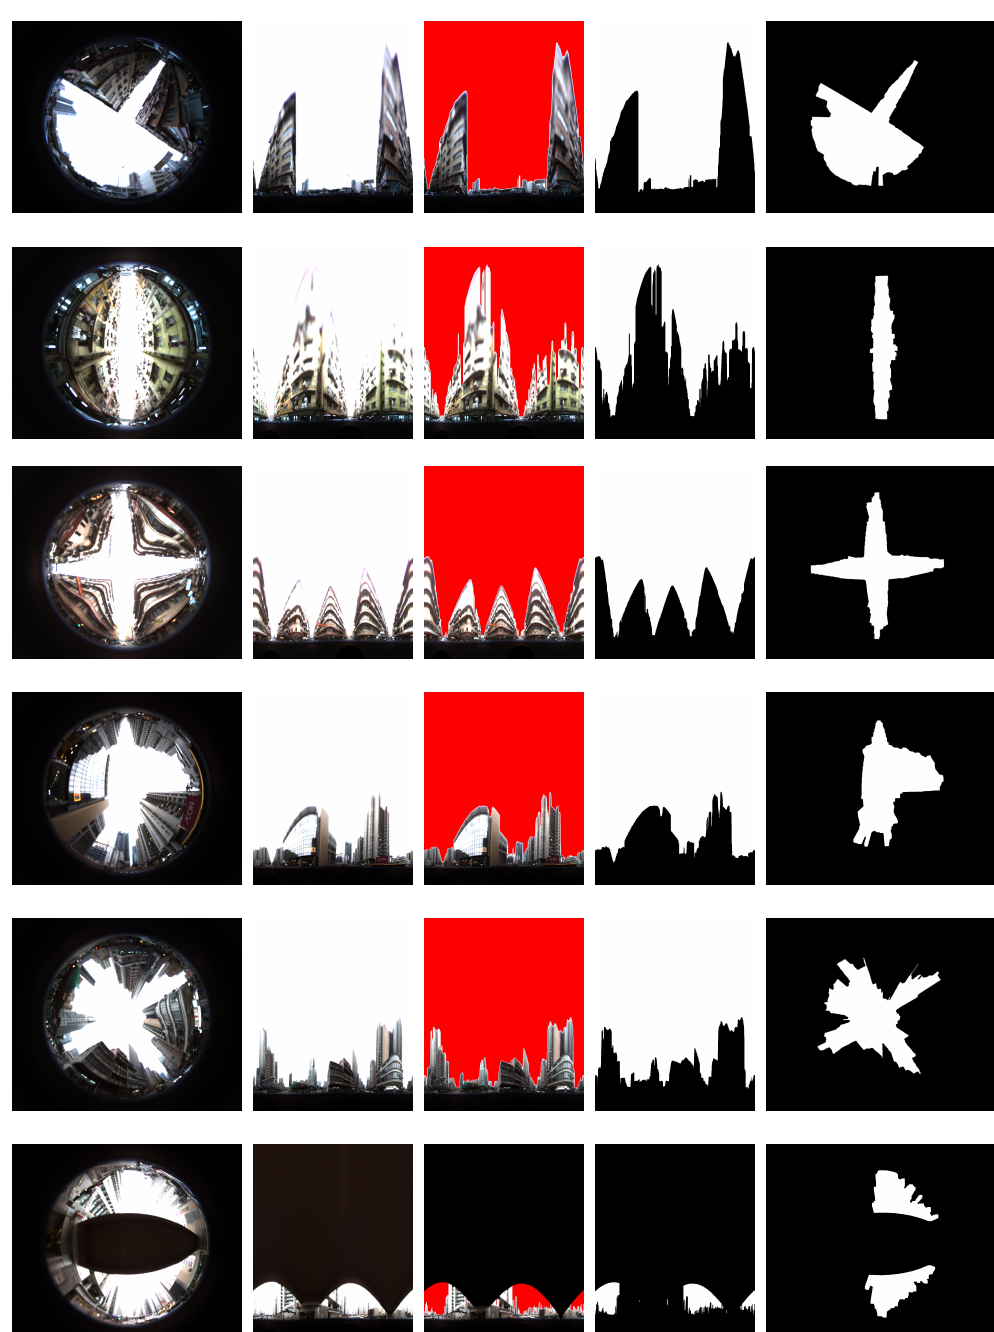
Figure 12. Qualitative evaluation of sky region segmentation. The first column shows the original images, the second column shows the rectified images, the third column shows the images after sky region segmentation, where the sky region is represented in red; the fourth column shows the binarized images obtained from images in the third column; and the fifth column shows the results of image morphology processing after conversion to omnidirectional